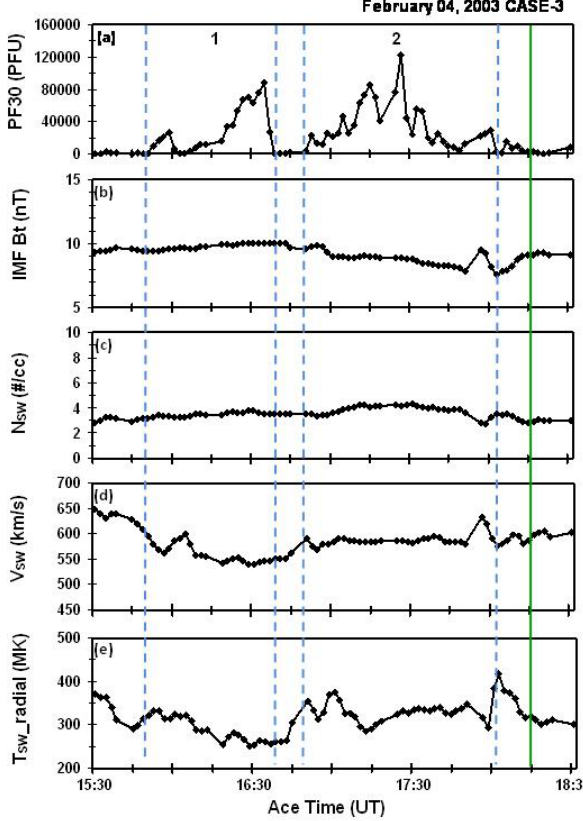
Fig. 16b. ACE solar wind plasma data for Case 3, 4 February 2003. From top to bottom, panels give (a) PF30, (b) IMF strength, (c) den- sity, (d) speed, and (e) proton temperature (radial) versus time. PF30 was added to guide the features in Cluster data. IMF strength was included for easy comparison. Cluster data were shifted to the Figure 16a ACE times concurrently to account for the solar wind convection Fig. 16a. ACE magnetic field data for Case 3, 4 February 2003. time from ACE to Cluster. Horizontal axis indicates the time at From top to bottom PF30, IMF strength, IMF B x , IMF B y , IMF ACE B z , and IMF clock angle. PF30 was added to guide the features in Cluster data. Cluster data were shifted to the ACE times concur- rently to account for the solar wind convection time from ACE to Cluster. Horizontal axis indicates the time at ACE spacecraft.